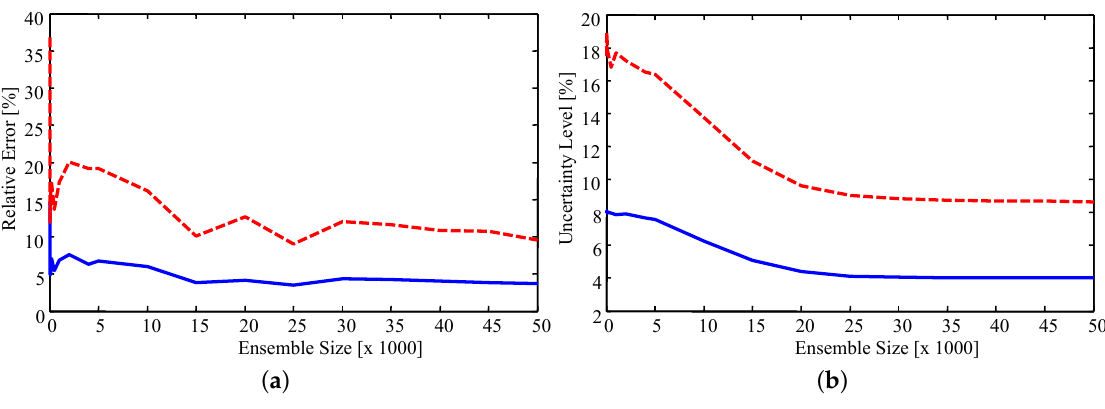
Figure 7. ( a ) Relative error of the estimates; and ( b ) relative uncertainty for increasing ensemble size. Solid blue line: average; dashed red line: maximum.